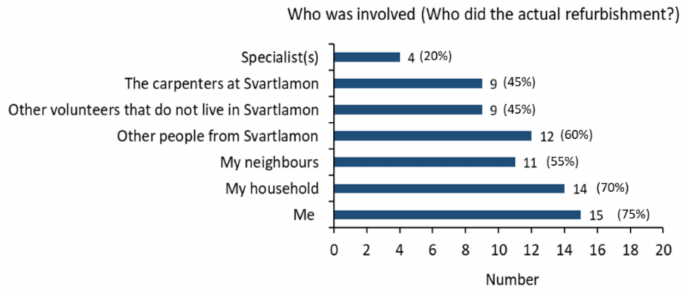
Figure 18. Involved groups in renovation plans.